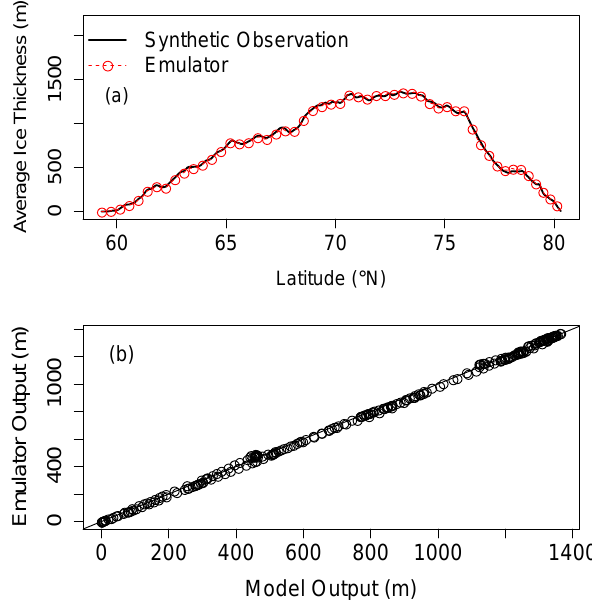
Figure 2. Comparison of zonal mean ice thickness transects from the assumed-true model run (#67 from Applegate et al., 2012) and that generated by the trained emulator at the same parameter com- bination as used in the assumed-true model run. In the top panel, the assumed-true profile is shown by a solid black curve, and the emulator output is shown by a dashed red curve with circles. In the lower panel, each point stands for an individual latitude location. The red circles in the top panel fall almost exactly on top of the black curve, and the points in the lower panel fall almost exactly on a 1:1 line connecting the lower left and upper right corners of the plot. Thus, the emulator successfully recovers the ice thicknesses from an assumed-true model realization when trained on the other model runs from the same ensemble. See Fig. S4 in the Supplement for results for other assumed-true model realizations.